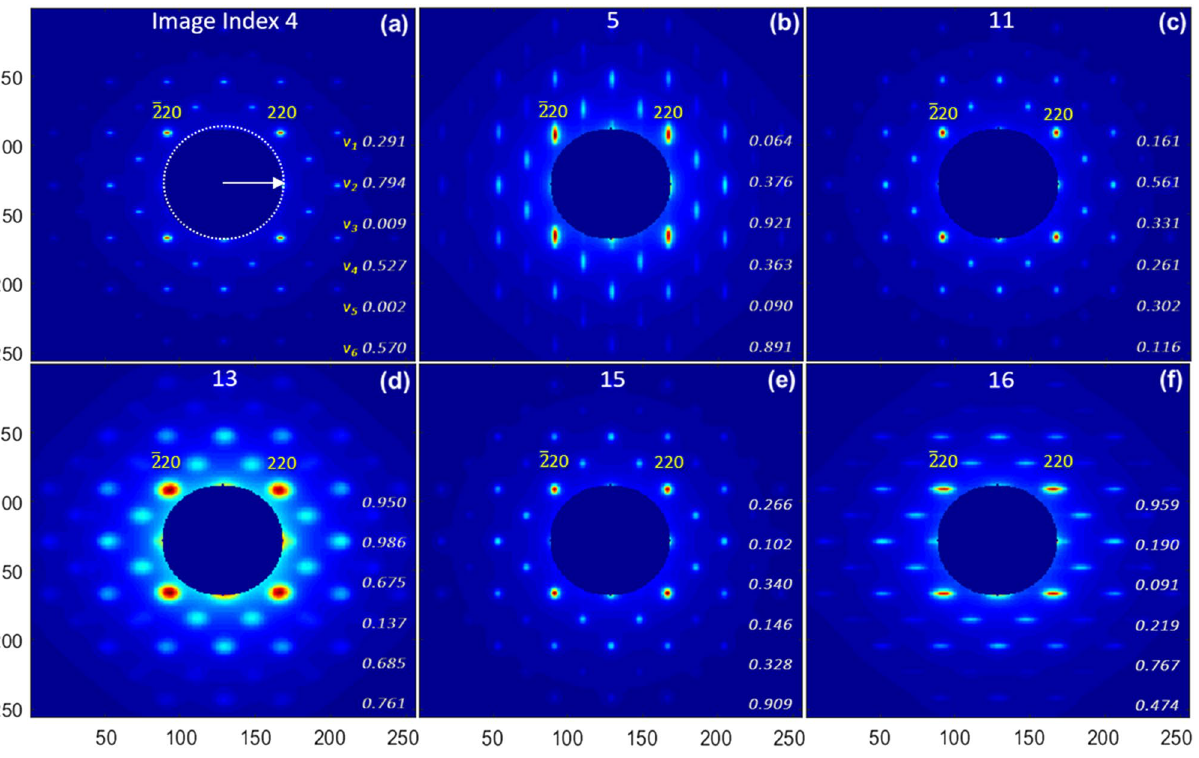
Figure 1. Simulated BD patterns of SrTiO 3 single crystal along [001] direction with the index 4 ( a ), 5 ( b ), 11 ( c ), 13 ( d ), 15 ( e ) and 16 ( f ), from left-to-right and top-to-bottom. The corresponding training variables are listed as the data array on the right side of a BD pattern. Each image has the size of 65,536 (= 256 × 256) pixels, with the angular resolution of 20 pixel/mrad in the EDP simulation. For each image, the x and y view angles are ¯ 220 the same, ± 6.40 mrad. Miller indexes of selected Bragg peaks, ( ) and (220), are labeled (yellow). The cutoff radius, shown as the white dashed circle in the middle of Fig. 1a, represents the hole in the middle of the mirror which is part of the detector system. The detector includes a phosphor screen and a downstream mirror with a hole in the middle. The hole allows the background noises generated by the core of the non-interacted electron beam and by the dark current to pass through the mirror to the beam dump.